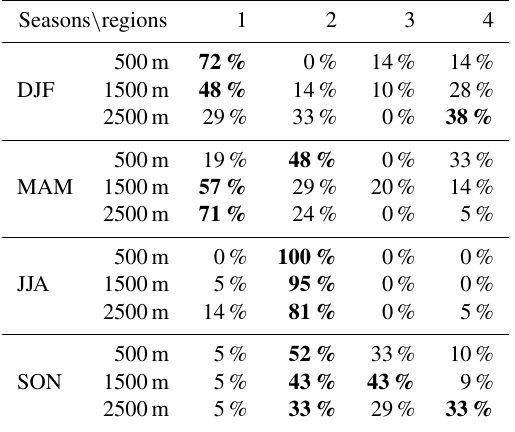
Table 3. The influence of various aerosol sources over the Bay of Bengal given as a percentage of the trajectories originating from each source respectively. The maximum influence is given in bold. The different source regions are explained in the text and in Fig.